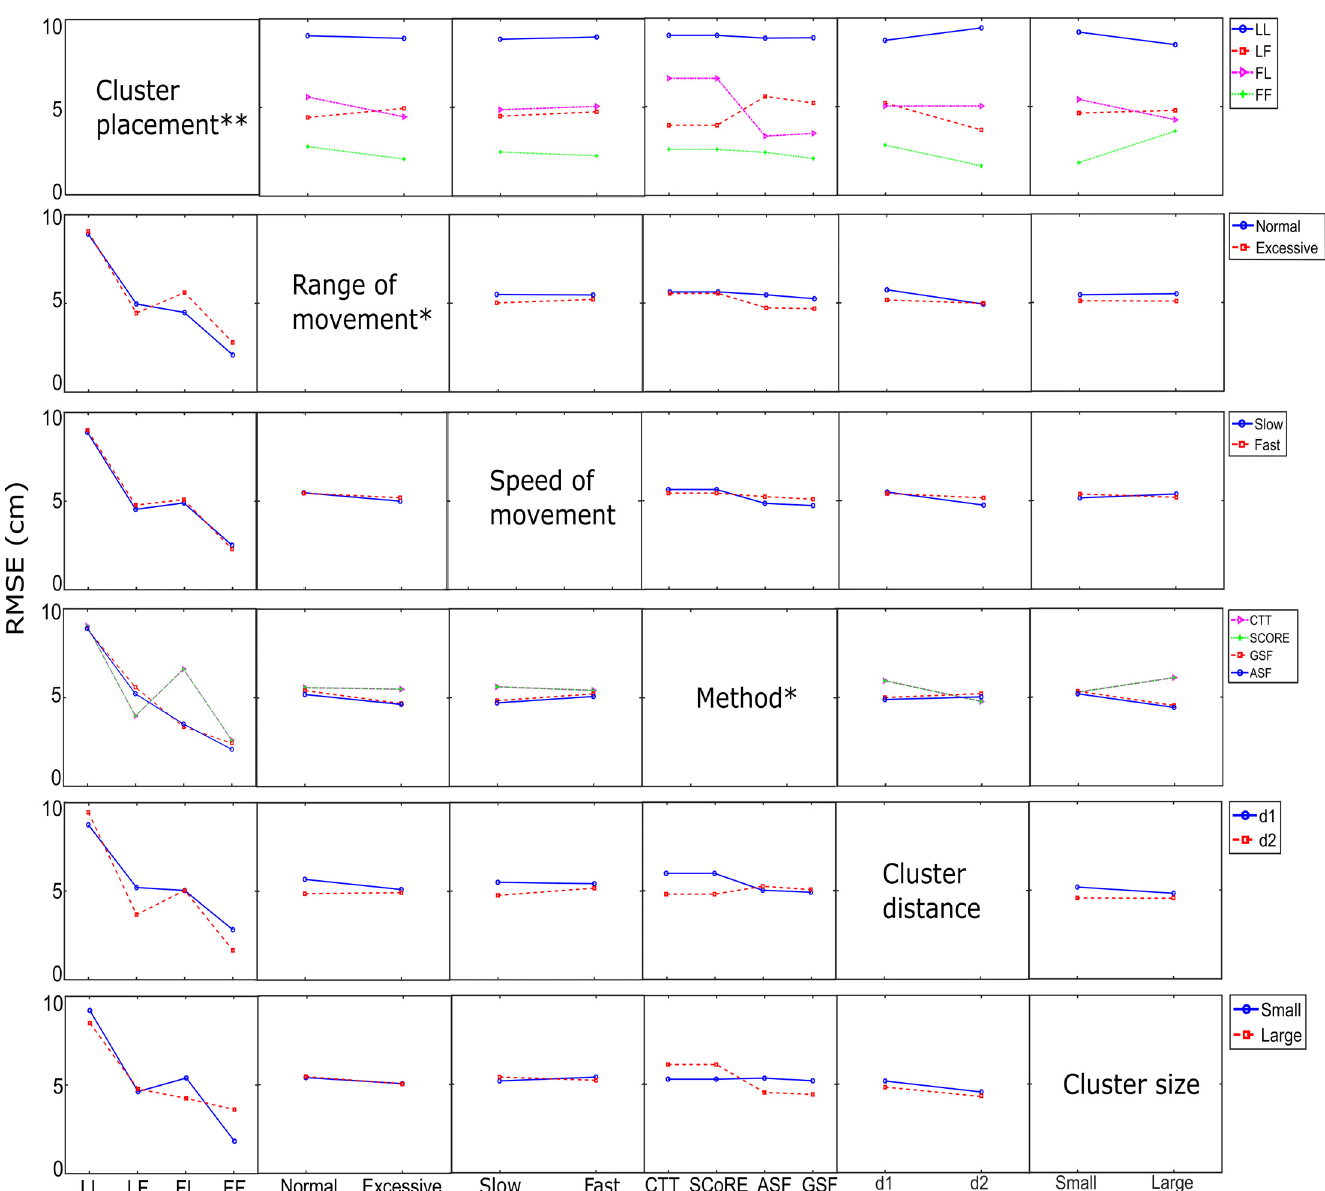
Fig 2. General linear model ANOVA effect matrix applied to the CoR estimation error (RMSE). Results demonstrated that the cluster placement, range of movement, functional methods have significant influence on the results. Significant effects at α < 0.05 are denoted with � and α < 0.001 with �� .